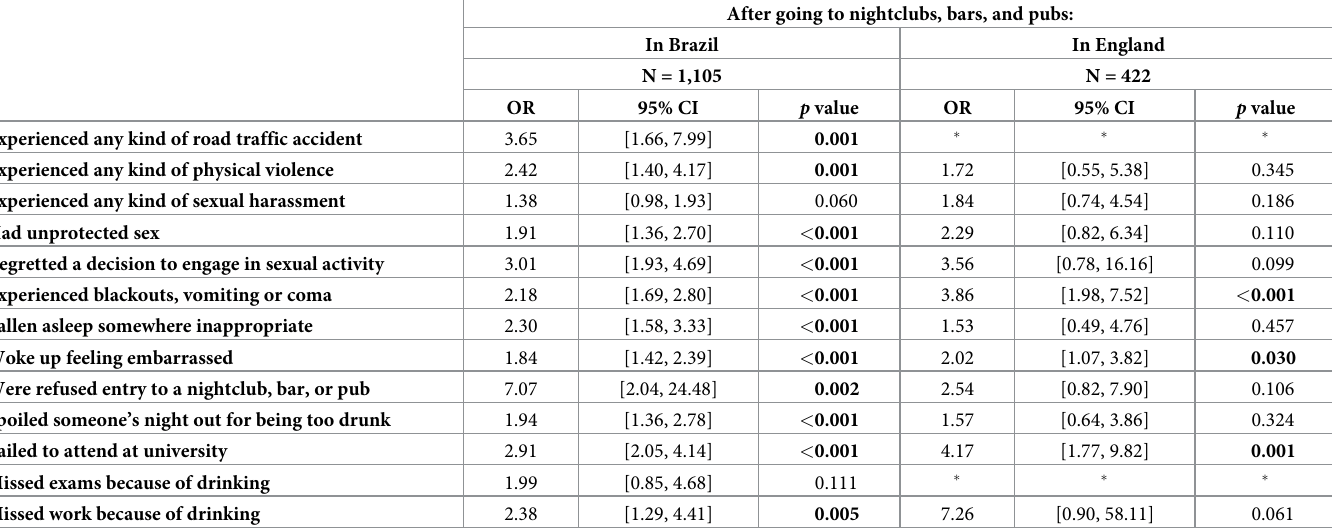
Table 6. Pre-drinking behaviour as a risk factor for alcohol-related harms after attending nightclubs, bars, and pubs amongst Brazilian and British university students.